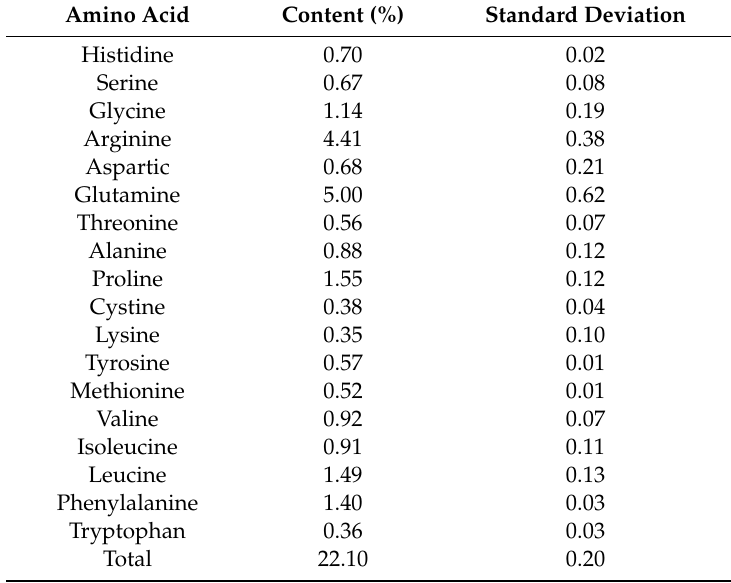
Table 1. The amino acids contents in protein extracted from Moringa (MO) seeds. Amino Acid Content (%)